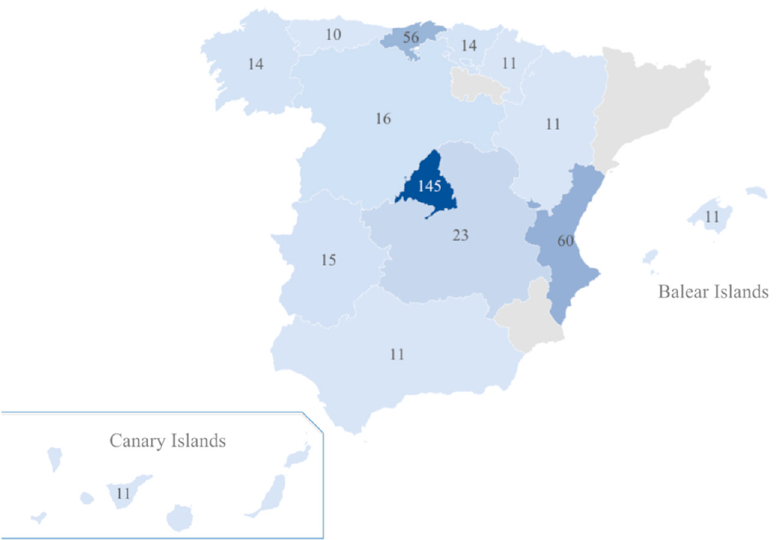
Figure 1. Sample frequency distribution. Own elaboration.